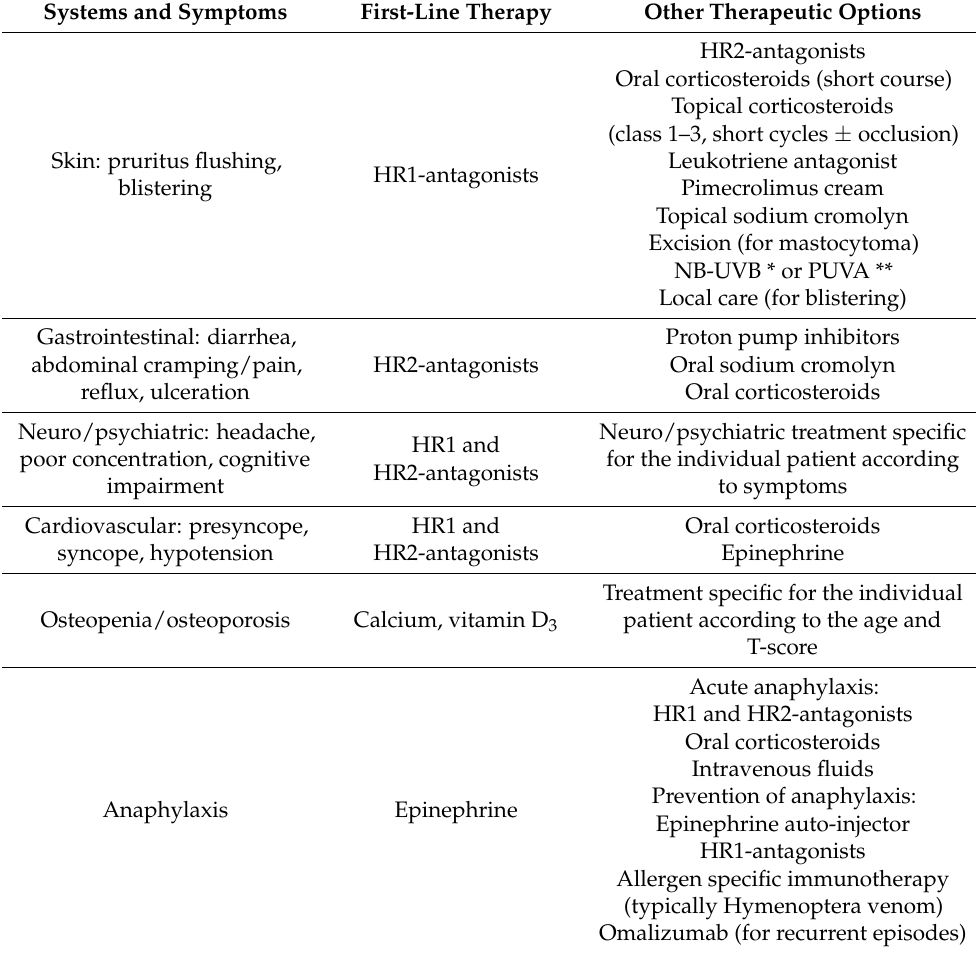
Table 4. Major treatment options for symptom control in pediatric